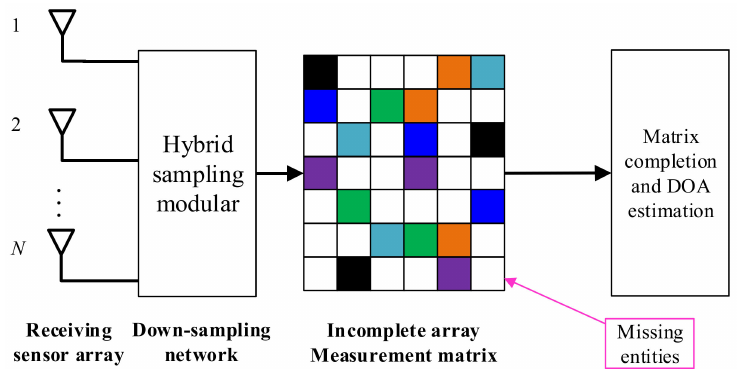
Figure 7. An example of a hybrid CS for DOA